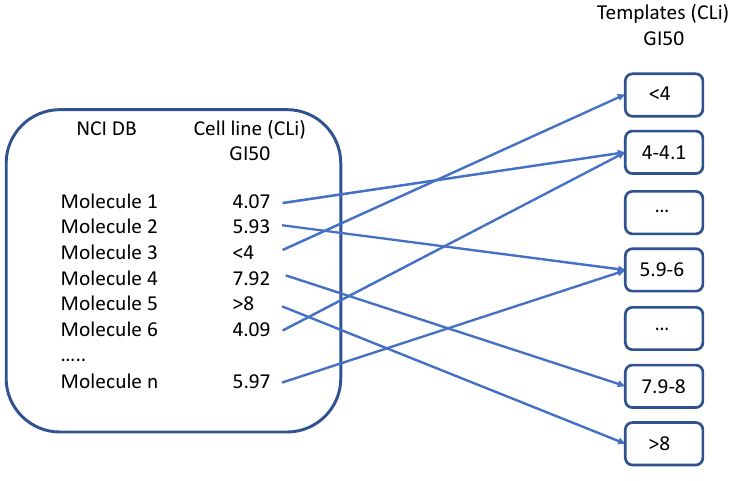
Figure 3. Template building process.